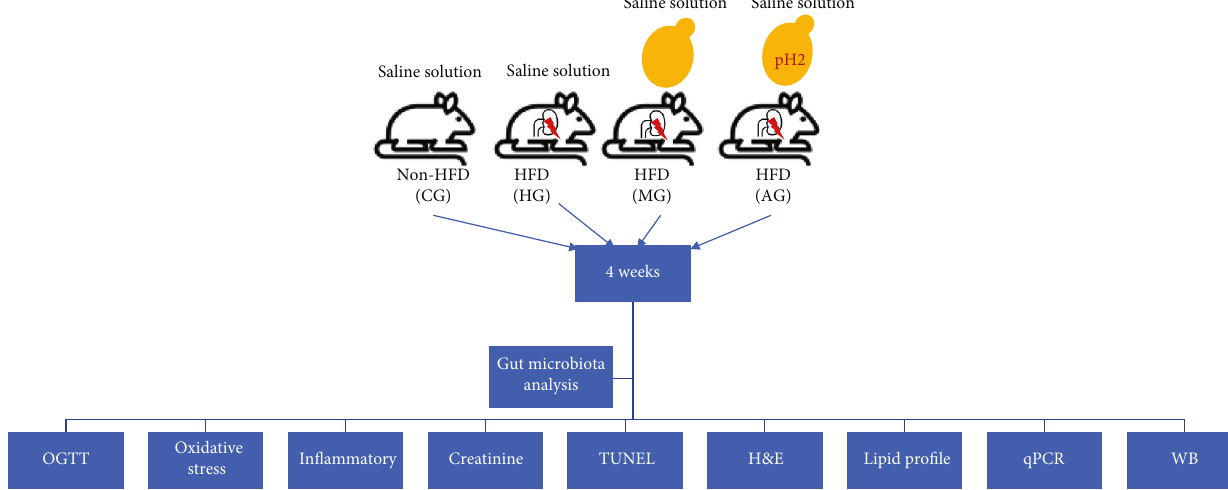
Figure 1: The fl ow chart of this study. n = 8 for each